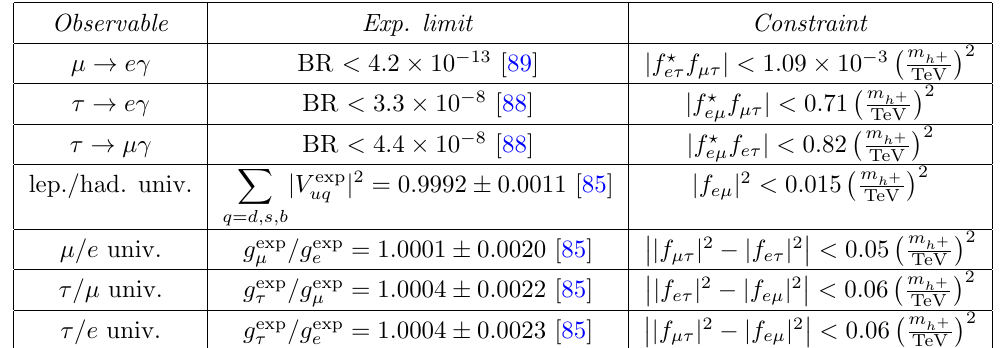
Table 19 . Constraints on the singly-charged scalar Yukawa couplings [205]. Here g exp the e(cid:11)ective gauge coupling extracted from muon and tau decays in the di(cid:11)erent leptonic channels.